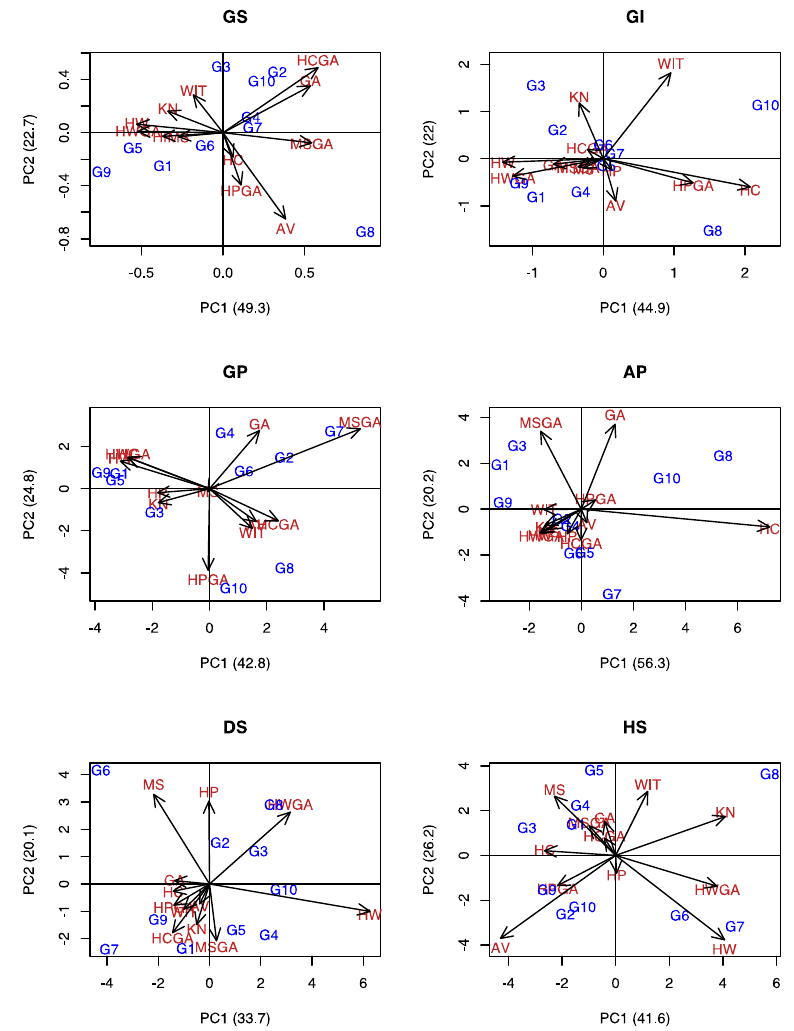
Figure 1. Principal component analysis of physiological variables of interaction Treatment by Genotype, (GS) Germination speed, (GI) Germination index, (GP) Germination percentage, (AP) Abnormal seedlings, (DS) Dead seeds, (HS) Hard